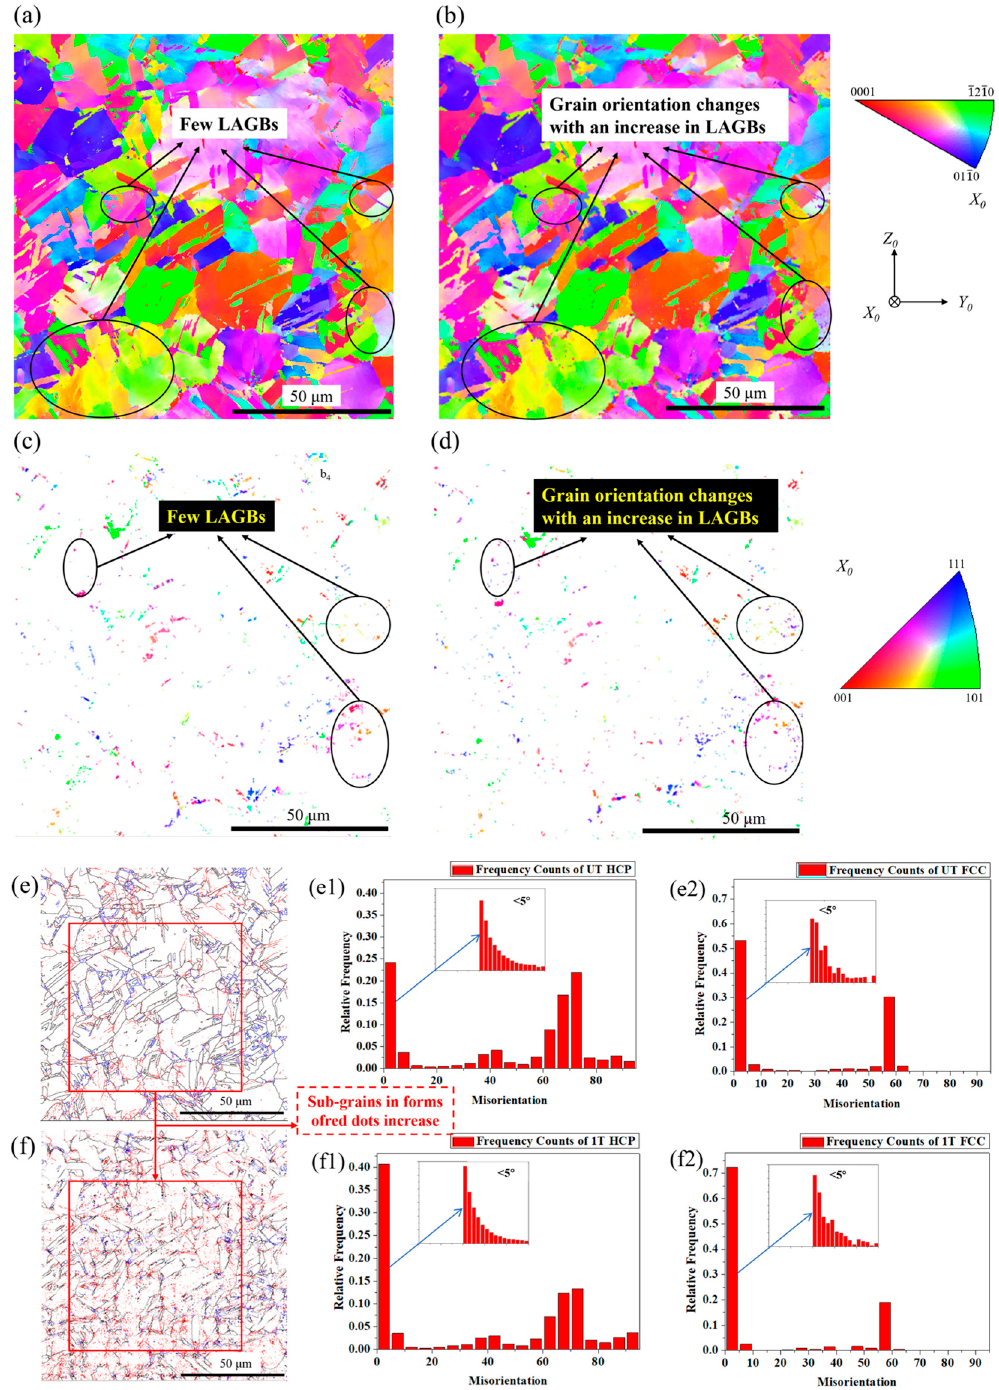
Figure 4. Inverse pole figures (IPFs), grain boundary misorientations and relative frequencies ( e1 , e2 , f1 , f2 ) of bulk cobalt. ( a ) HCP-UT, ( b ) HCP-1T, ( c ) FCC-UT, ( d ) FCC-1T, ( e ) UT, ( f )